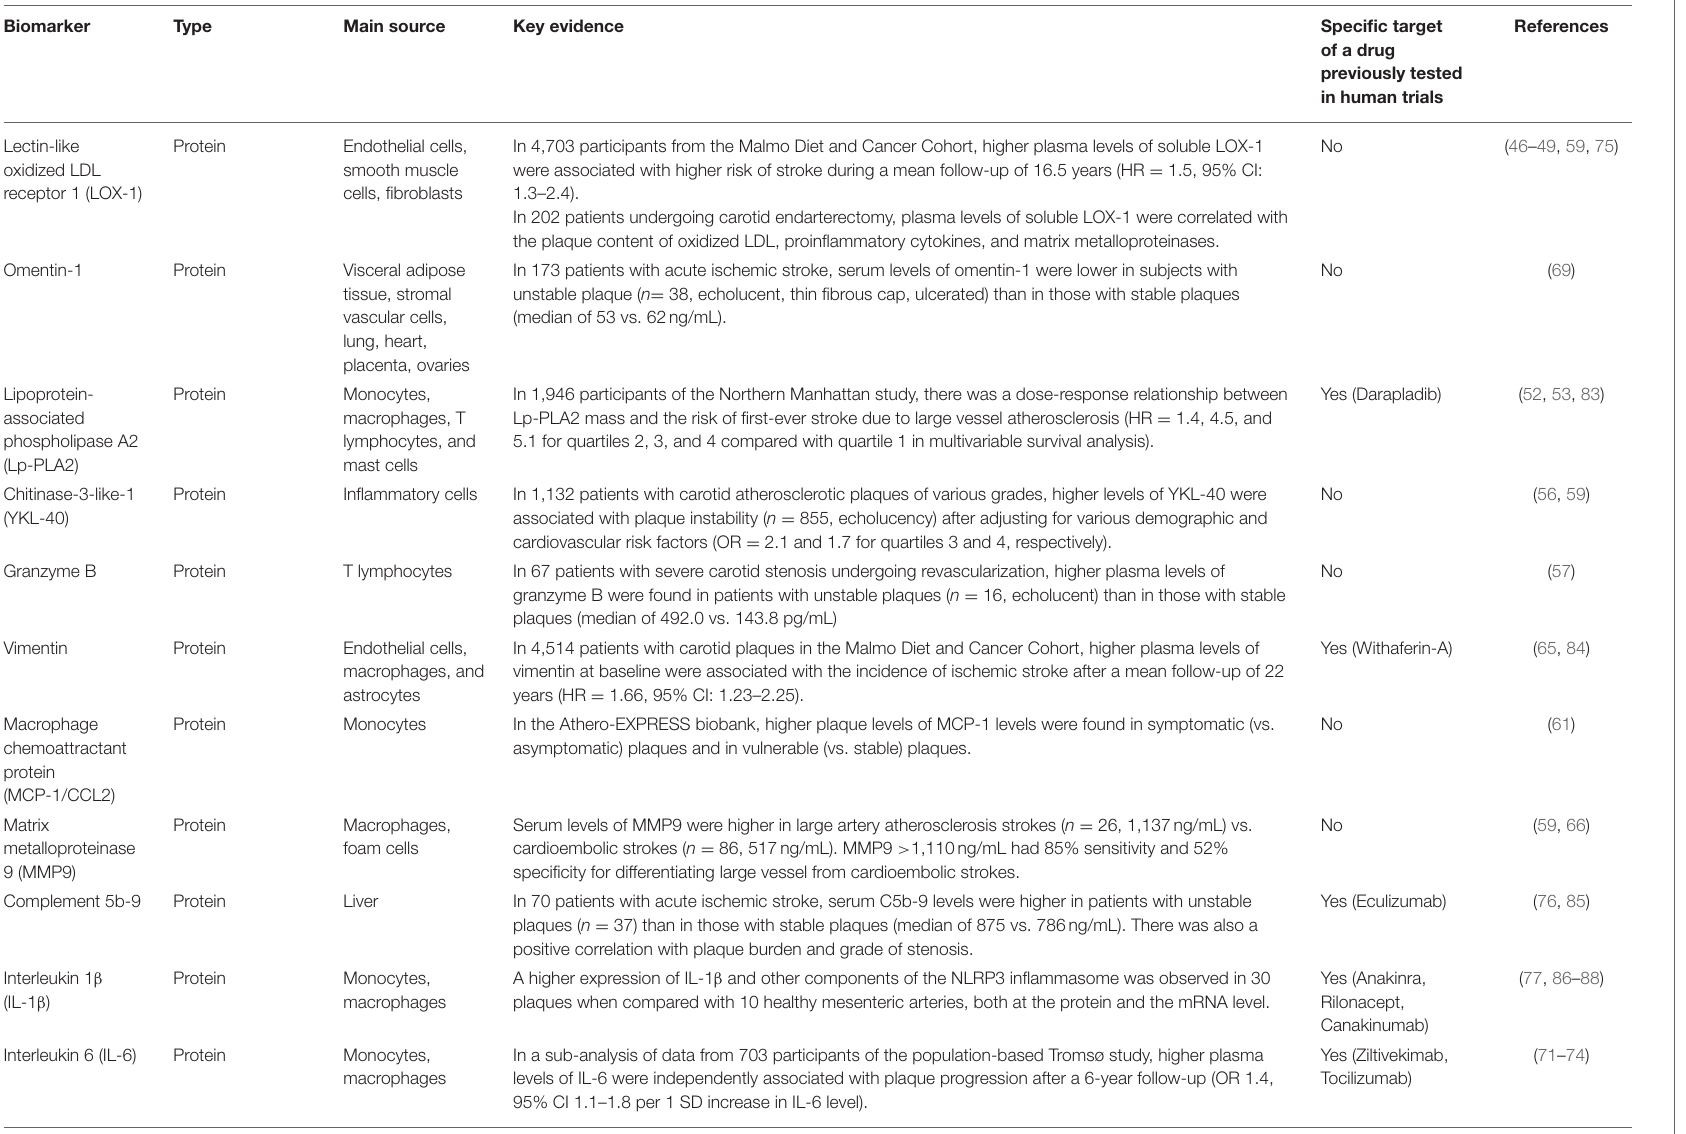
TABLE 3 | Biomarkers of potential interest for the study of non-stenotic carotid plaques in ESUS.